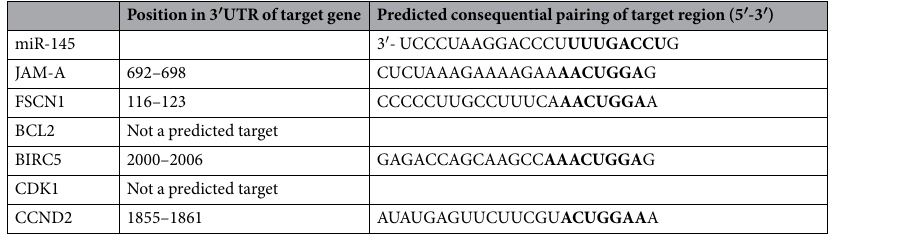
Table 2. Predicted Target Genes of